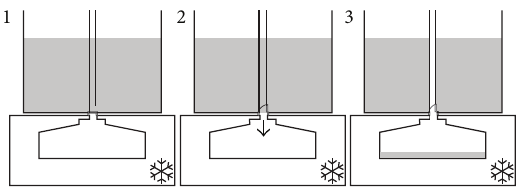
Figure 2: Schematic view of the device process. Step 1. A fifteen- second pause to ensure that there is no turbulence in the liquid during which the inside bin and the container are connected while the receptacle and inside bin are not. Step 2. Disconnection of the inside bin and the container resulting in separation of one- twentieth of the sample. Step 3. Connection of the inside bin and the receptacle. The device will stay in this phase for 15 seconds allowing complete discharge of the inside bin content to the